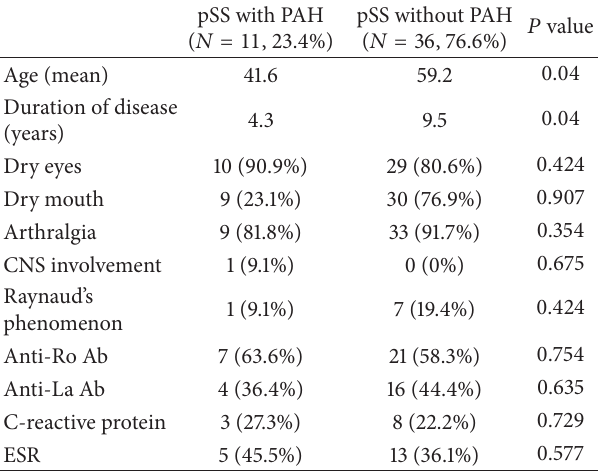
Table 2: Comparison of demographic and clinical features in pSS patients with and without pulmonary artery